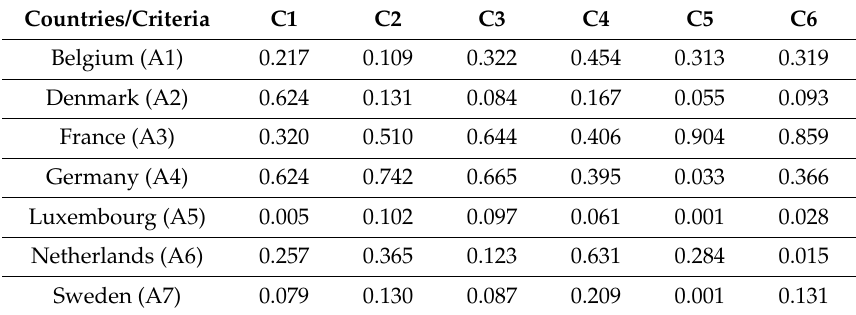
Table 10. Normalized criterion matrix for the international transport and energy export in 2016.